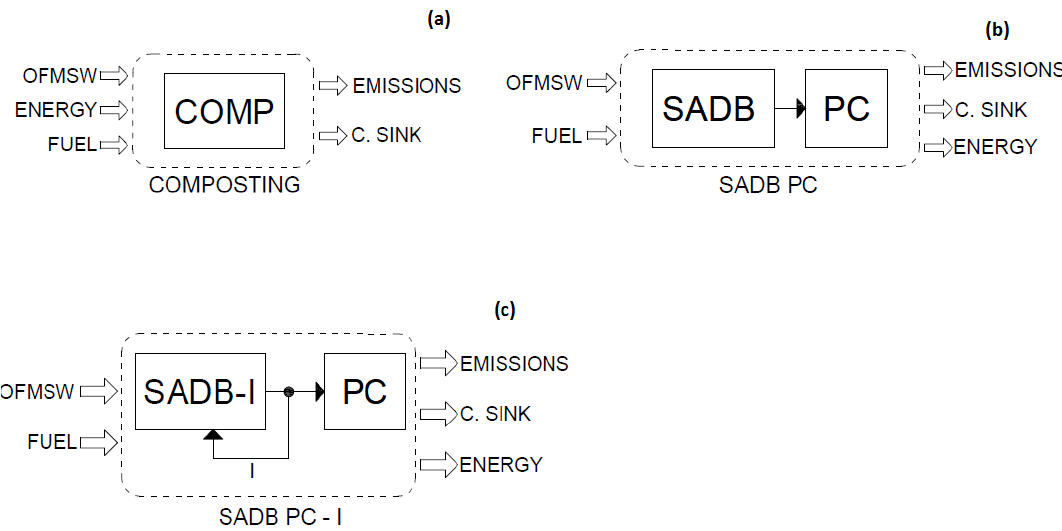
Figure 2. System boundaries for ( a ) composting (COMP), ( b ) solid anaerobic digestion batch and post-composting (SADBPC), and ( c ) solid anaerobic digestion batch with inoculum and post-composting (SADBPC-I).